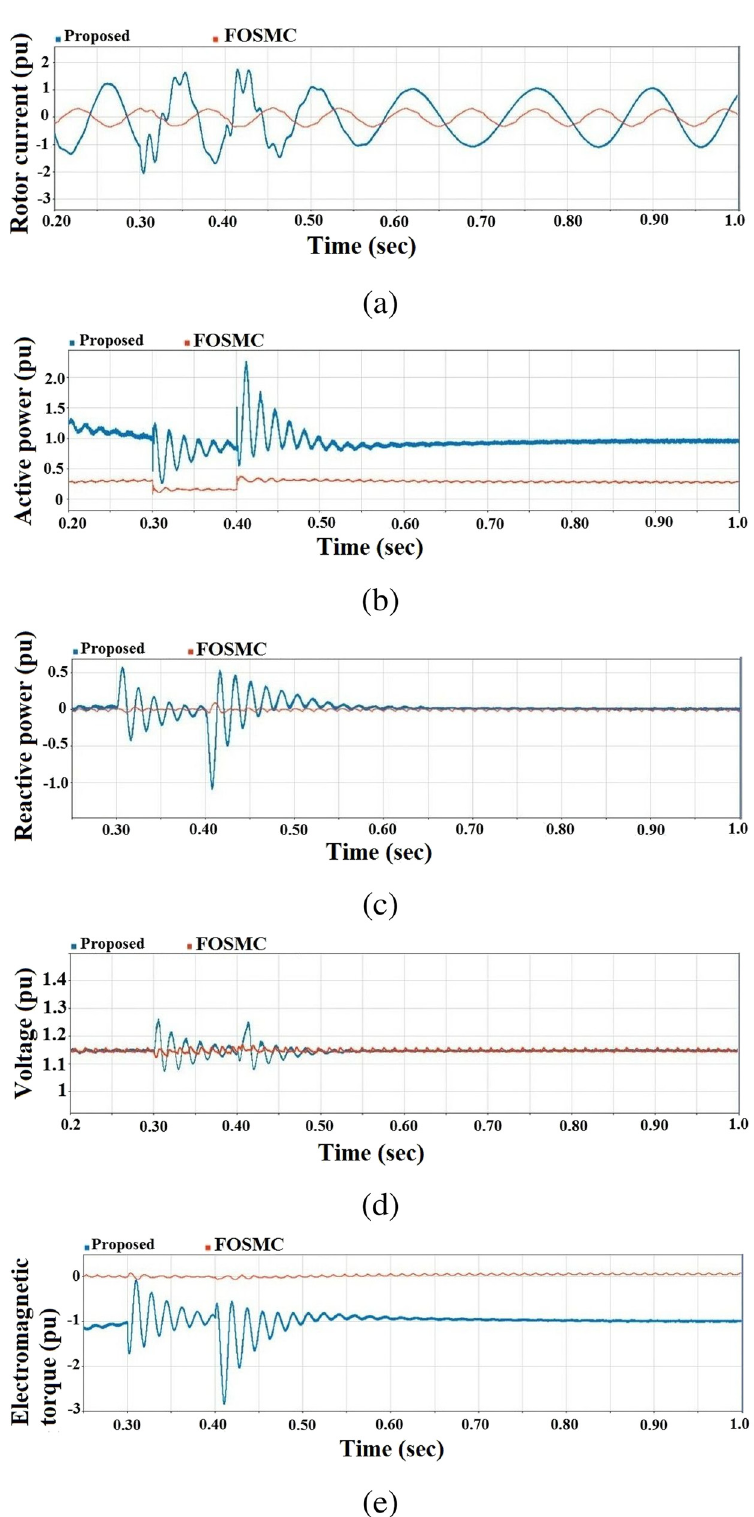
Figure 16: Comparison of FOSM and proposed controller during LVRT capability of DFIG system during grid fault: ( a ) rotor current, ( b ) active power, ( c ) reactive power, ( d ) DC - link voltage, and ( e ) electromagnetic